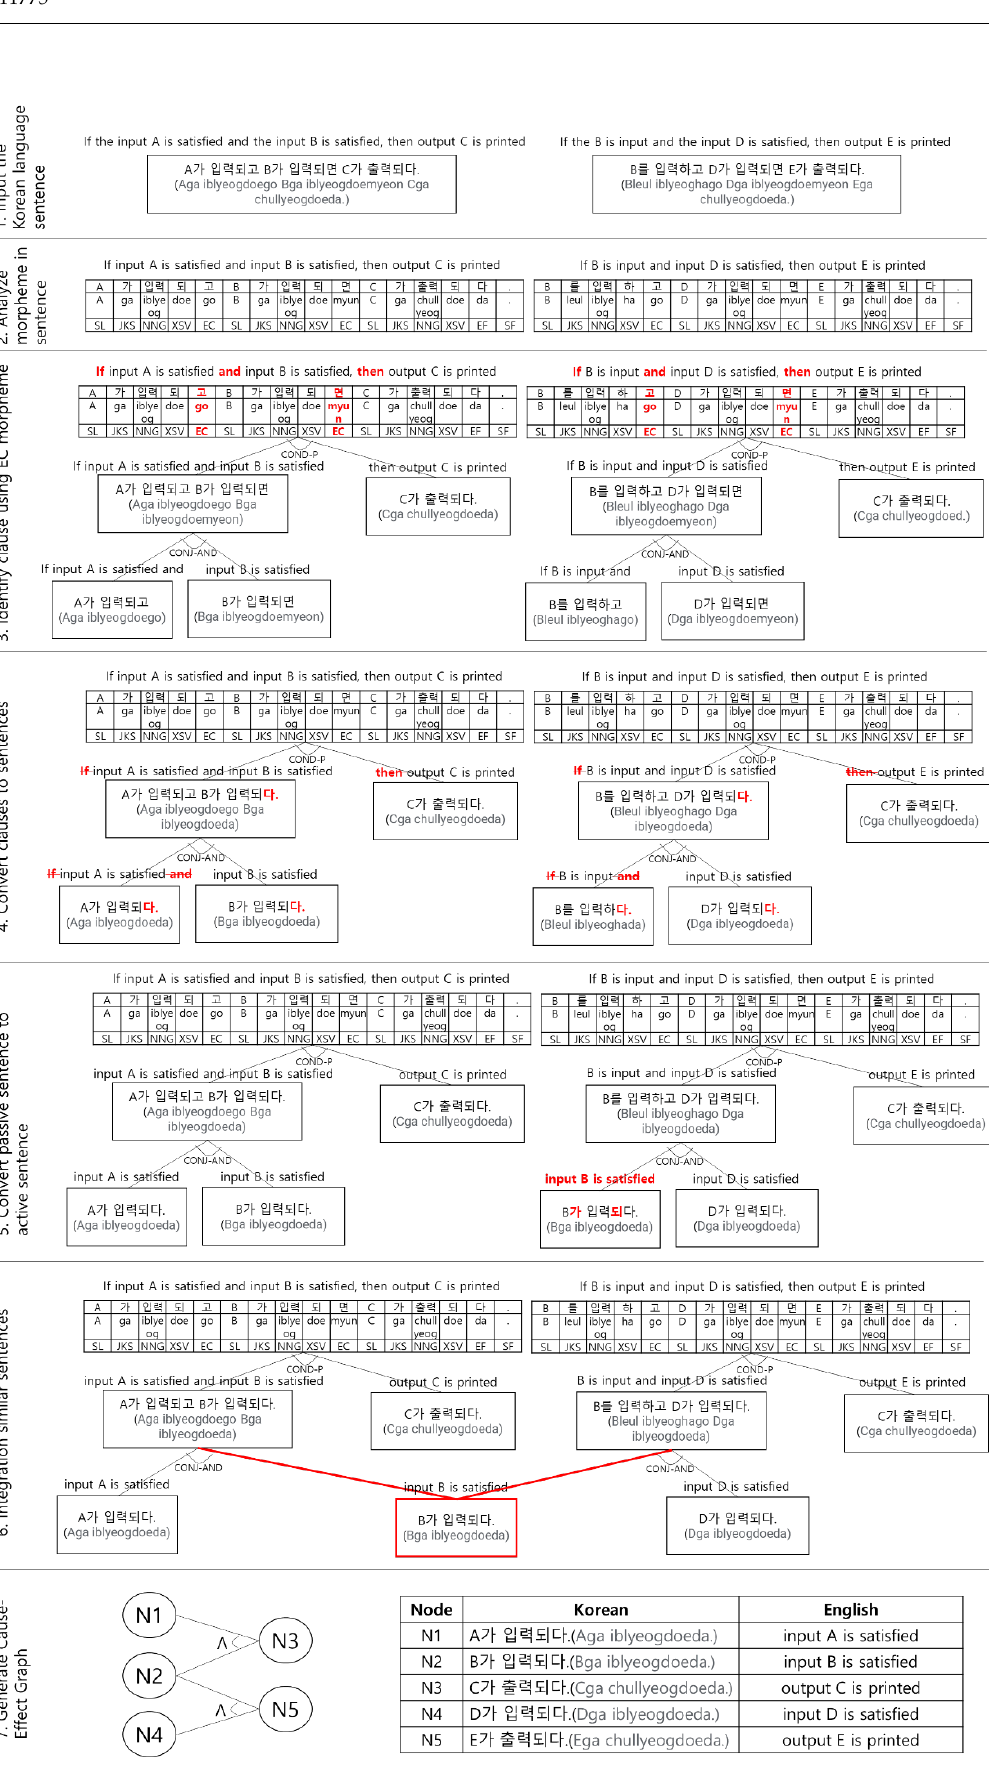
Figure 10. Our automatic generation mechanism of the Korean Requirements Analyzer for Cause-Effect Graph.